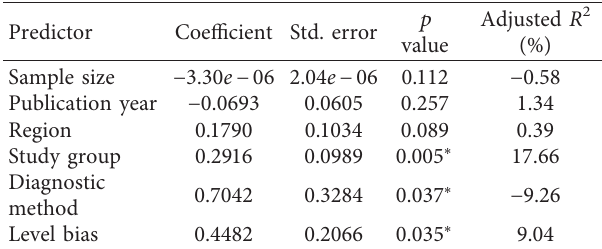
Table 3: Meta-regression analysis of factors for the heterogeneity of anti-HCV prevalence in Ethiopia, 2020.